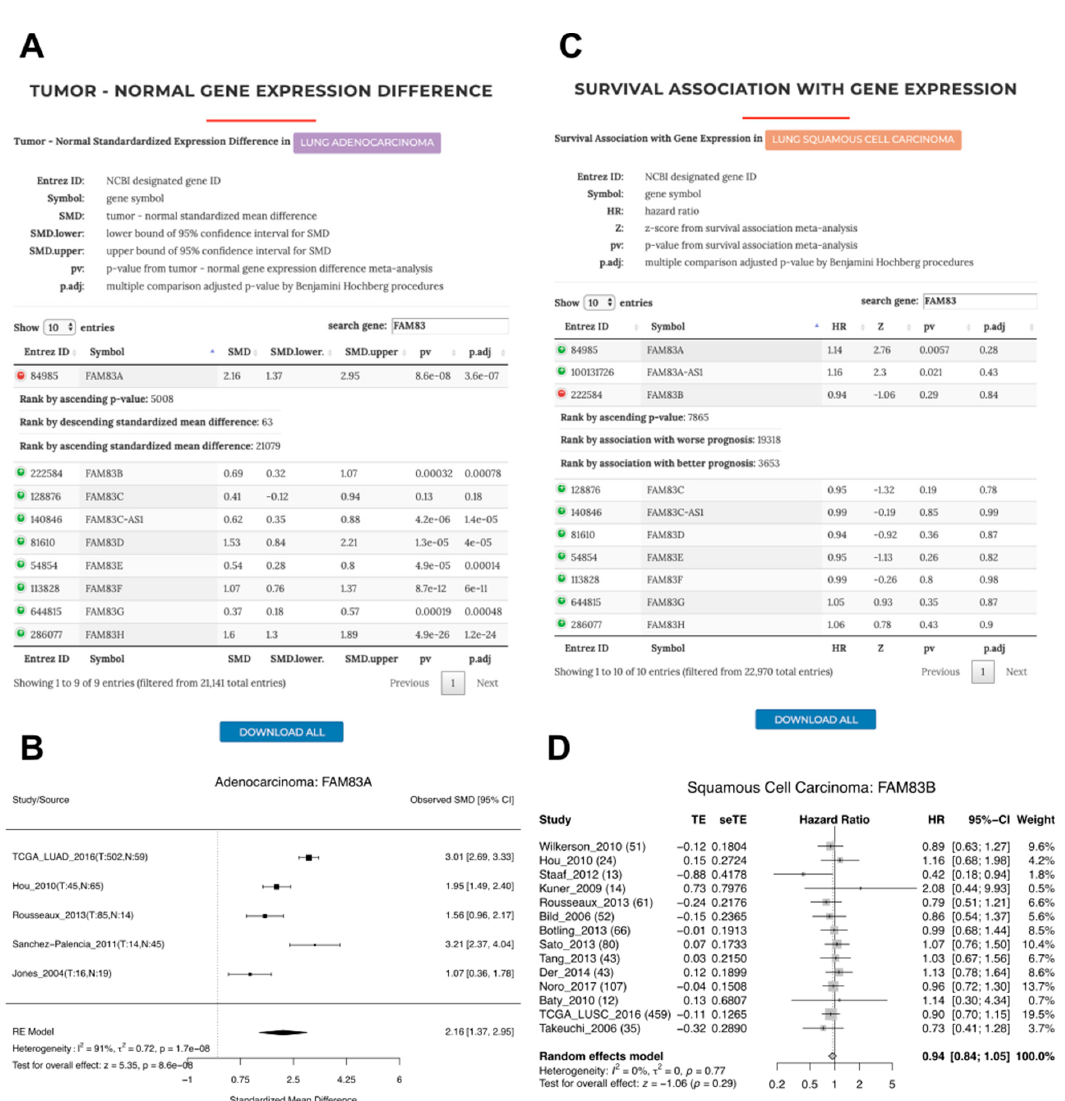
Figure 5. Tumor–normal expression difference of FAM83A in ADC and survival association with FAM83B expression in SQCC. ( A ) A snapshot of the systematic analysis results for tumor–normal expression difference in ADC on LCE. “FAM83” was entered into the search box so that the table was filtered to retain genes starting with FAM83. ( B ) Forest plot showing meta-analysis of the tumor–normal expression difference in ADC for FAM83A . ( C ) A snapshot of the systematic analysis results for the survival association with the FAM83 family gene expression in SQCC on LCE. ( D ) Forest plot showing the meta-analysis of association between FAM83A expression and overall survival in SQCC.